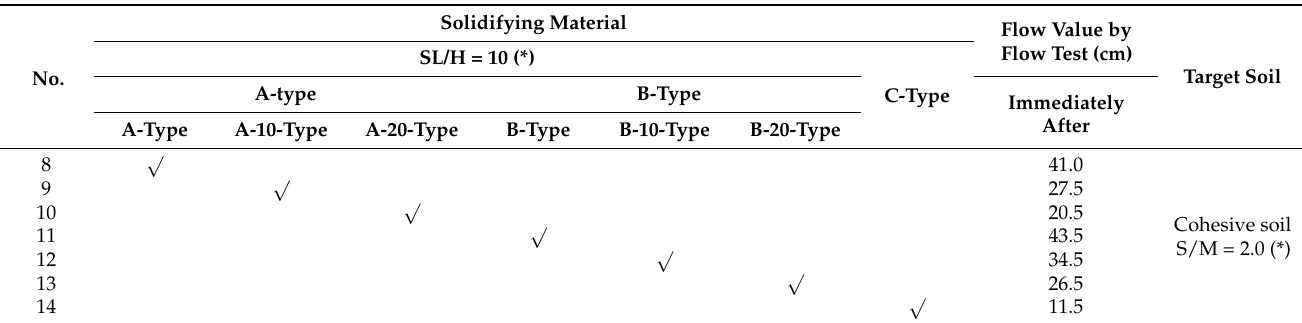
Table 3. Results of the flow tests for the specimen mixed with cohesive soil and the slurry solution of each solidifying material.